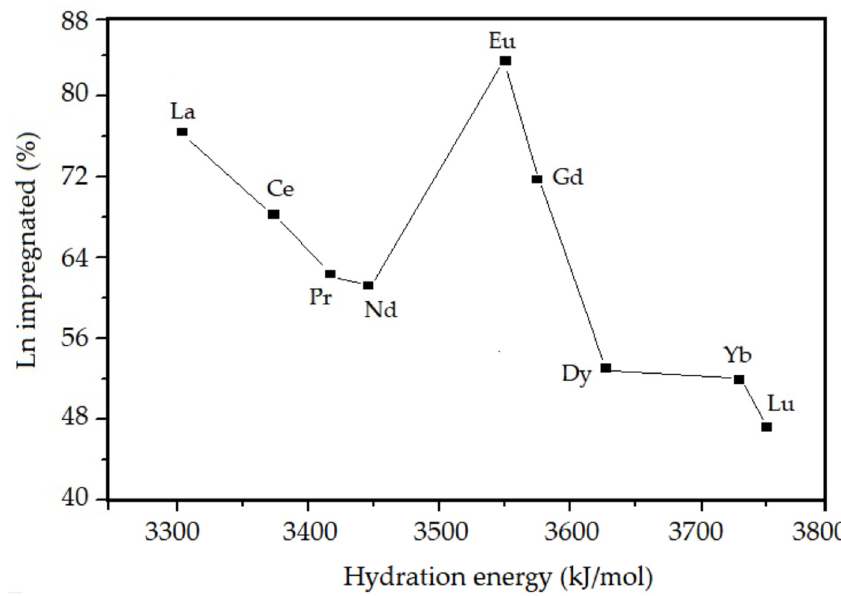
Figure 6. Lanthanide impregnated in the SiO 2 as a function of hydration energy.